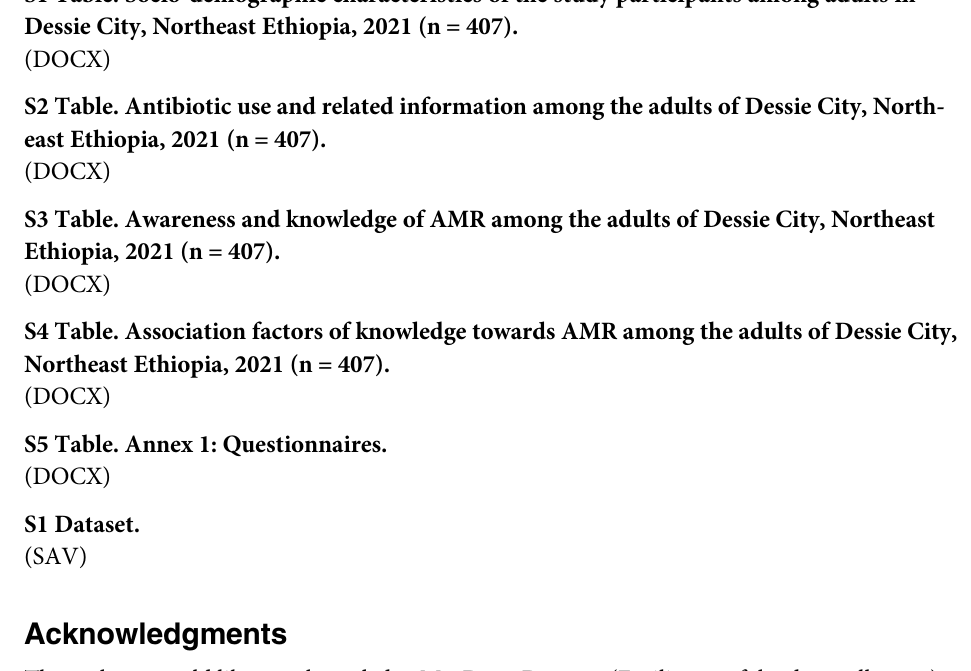
S1 Table. Socio-demographic characteristics of the study participants among adults in Dessie City, Northeast Ethiopia, 2021 (n = 407). S2 Table. Antibiotic use and related information among the adults of Dessie City, North- east Ethiopia, 2021 (n = 407). S3 Table. Awareness and knowledge of AMR among the adults of Dessie City, Northeast Ethiopia, 2021 (n = 407). S4 Table. Association factors of knowledge towards AMR among the adults of Dessie City, Northeast Ethiopia, 2021 (n = 407). S5 Table. Annex 1: